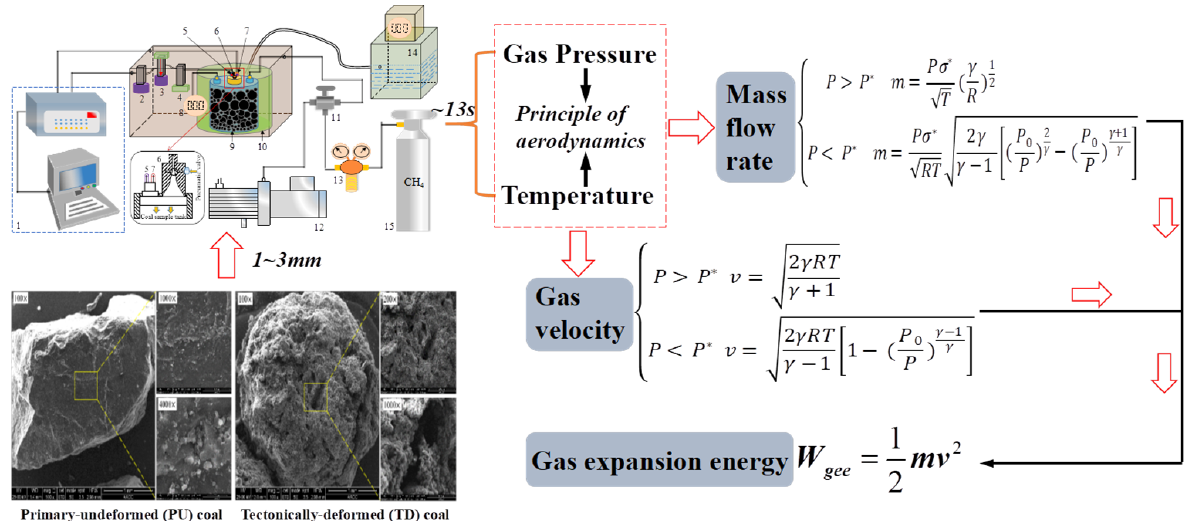
Figure 2. The flow of data processing.